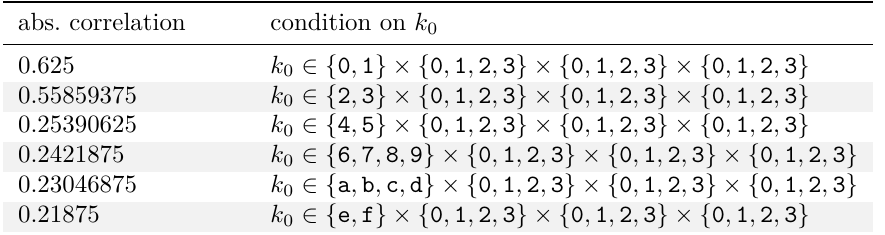
Table 2: Fixing the second round key k 1 = ( 0 , 0 , 0 , 1 ), this table shows all possible values for the absolute correlation of the approximation ( 8 , 8 , 8 , 8 ) → ( 8 , 8 , 8 , 8 ) over E G 00 , G for k 0 from the set of weak keys WK 00 .